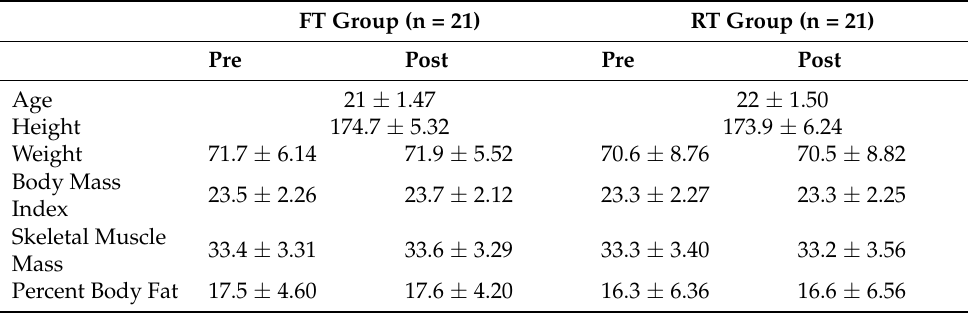
Table 2. Athlete characteristics (n =